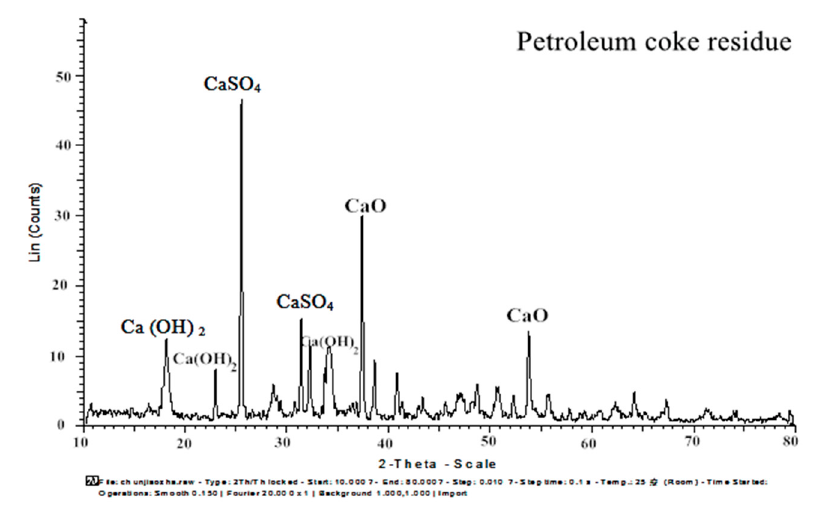
Figure 5. XRD map of petroleum coke residue. Table 3. Chemical composition results of different mineral admixtures by XRF.